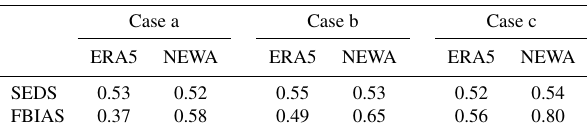
Table 5. Skill scores indicators for the two reanalyses and the three considered